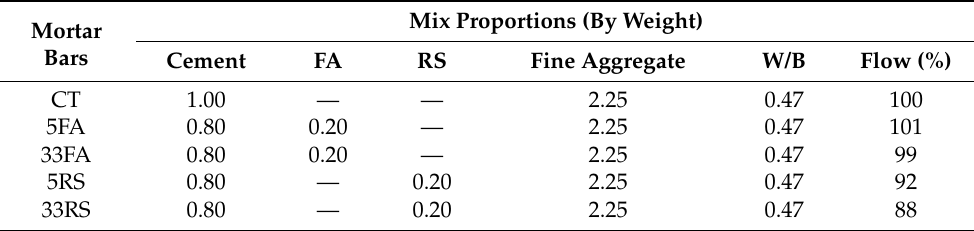
Table 3. Mix proportions of mortar bars in the alkali–silica reaction (ASR) investigation.